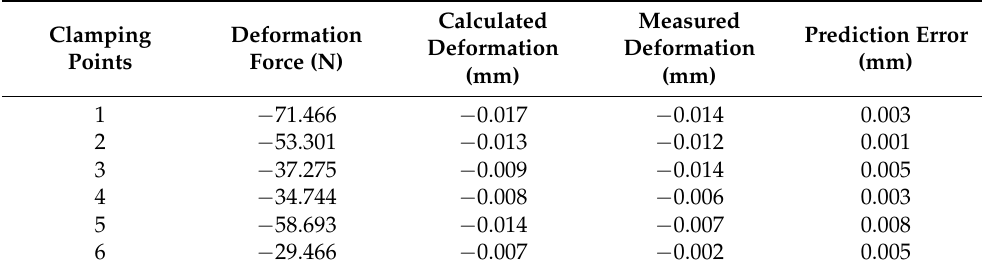
Figure 12. Deformation force at machining steps 15 to 20. Table 2. Deformation force monitoring data at machining step 20.